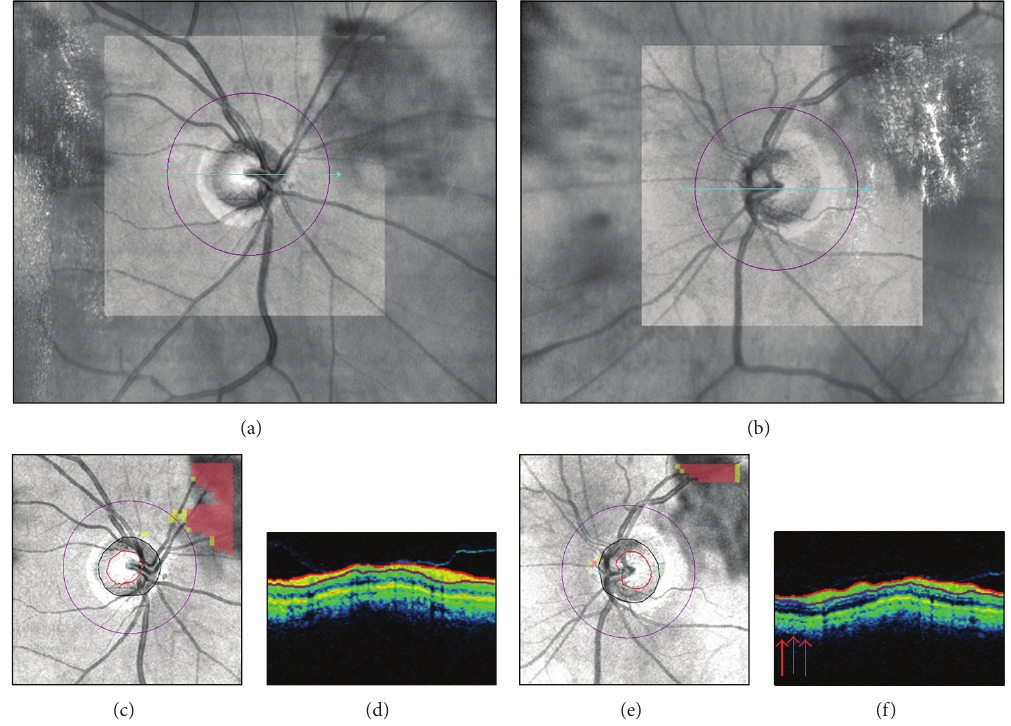
Figure 7: Smudged OCT lens. Live Cirrus HD-OCT funduscopic images ((a)-(b)), retinal nerve fiber layer (RNFL) deviation maps ((c), (e)), and circular tomograms ((d), (f)) from the two eyes of the same individual. A smudged OCT lens artifact in the superonasal and superotemporal peripapillary regions of the right and the left eyes, respectively, approached the corresponding sectors of the scan circle. In the right eye, note on the RNFL deviation map the yellow “superpixels” indicating localized RNFL thinning (c), despite apparent signal uniformity on the circular tomogram (d). In the left eye, note the discrete superotemporal area of signal attenuation on the circular tomogram ((f) arrows), possibly affecting the corresponding RNFL thickness